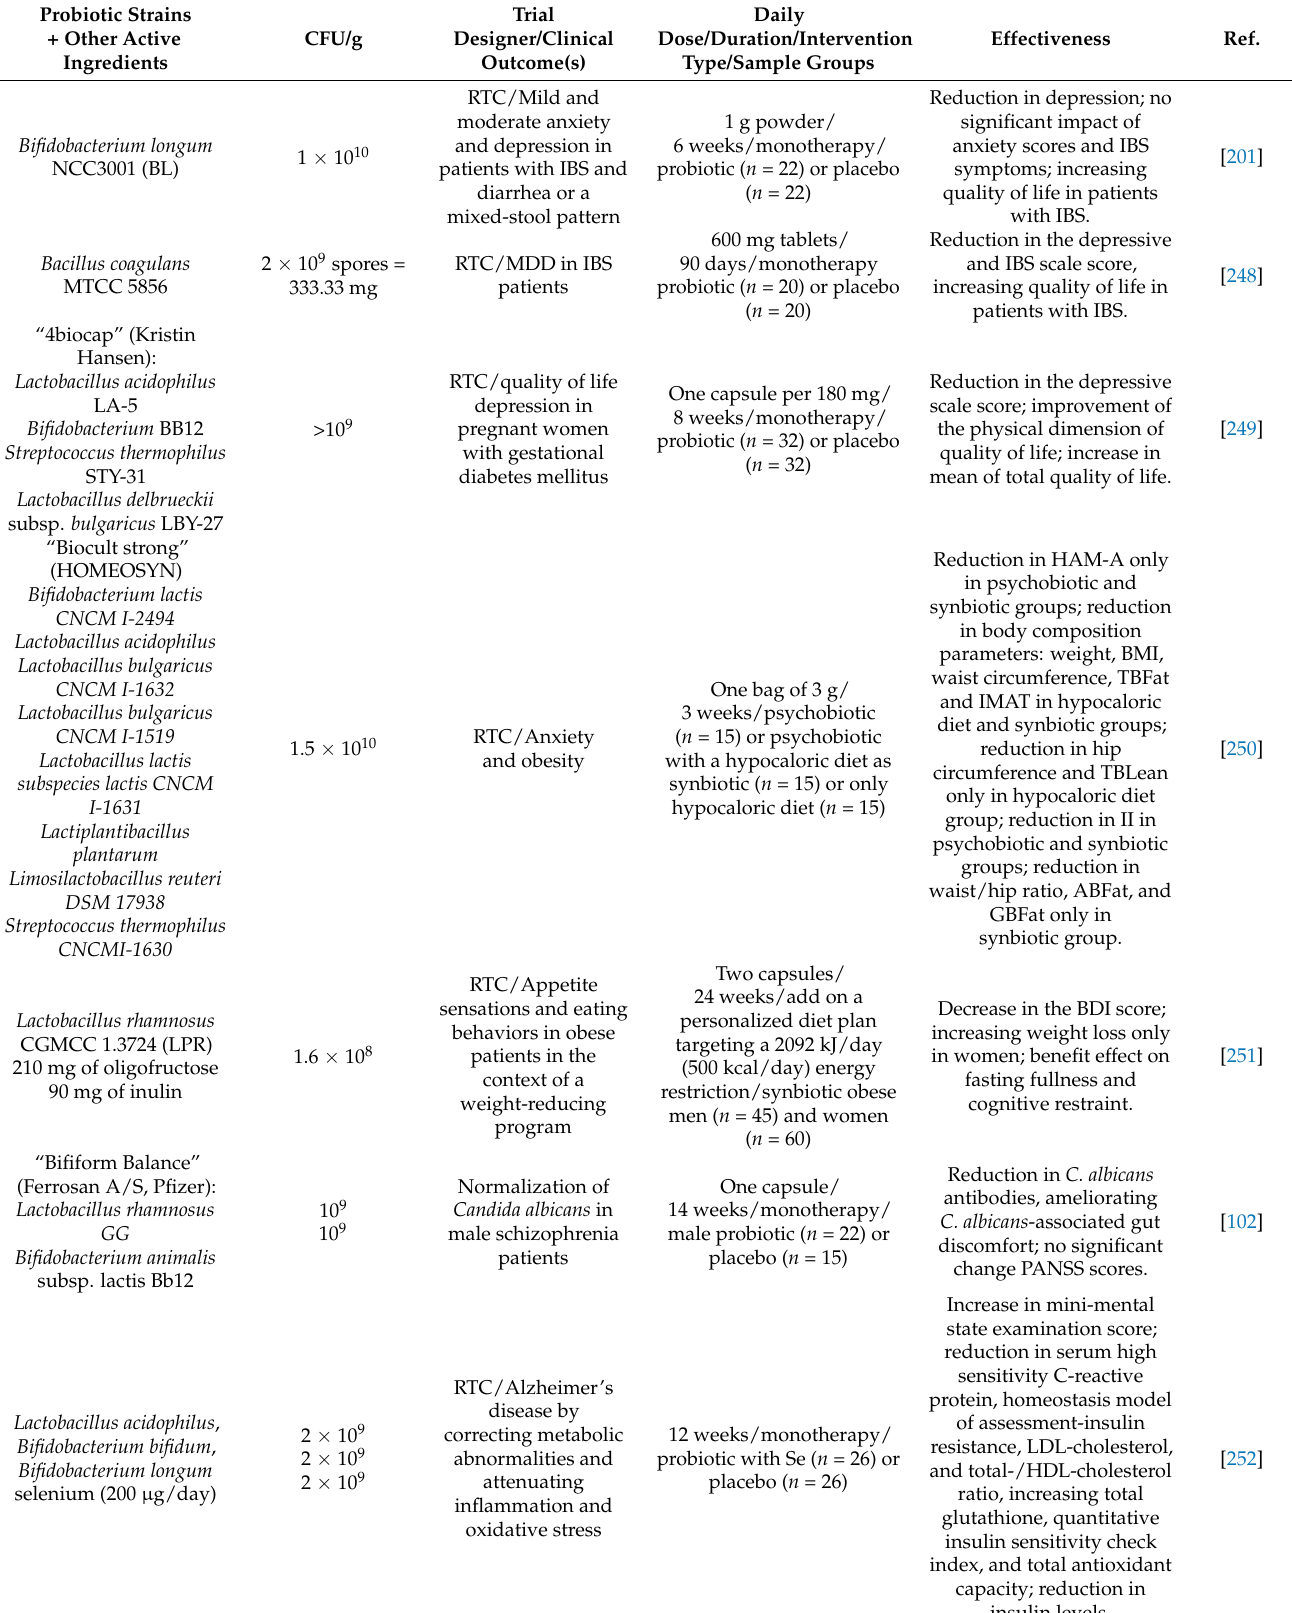
Table 4. Summary of the effectiveness of probiotic strains used as psychobiotics in clinical trials on metabolic